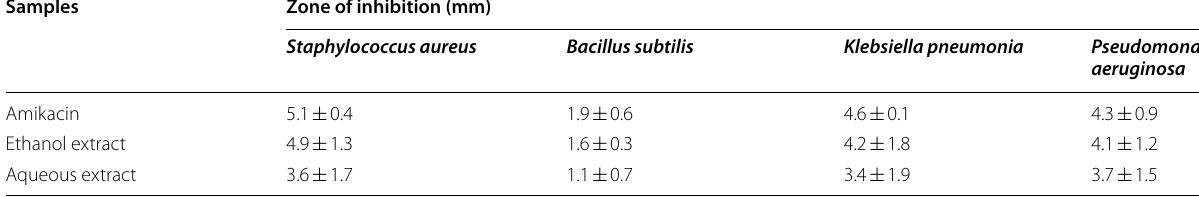
Table 2 Antibacterial activity of ethanol and aqueous leaf extracts of Suaeda maritima Samples Zone of inhibition (mm) Staphylococcus aureus Bacillus subtilis Amikacin Ethanol extract Mean Standard deviation; n 3 ± =